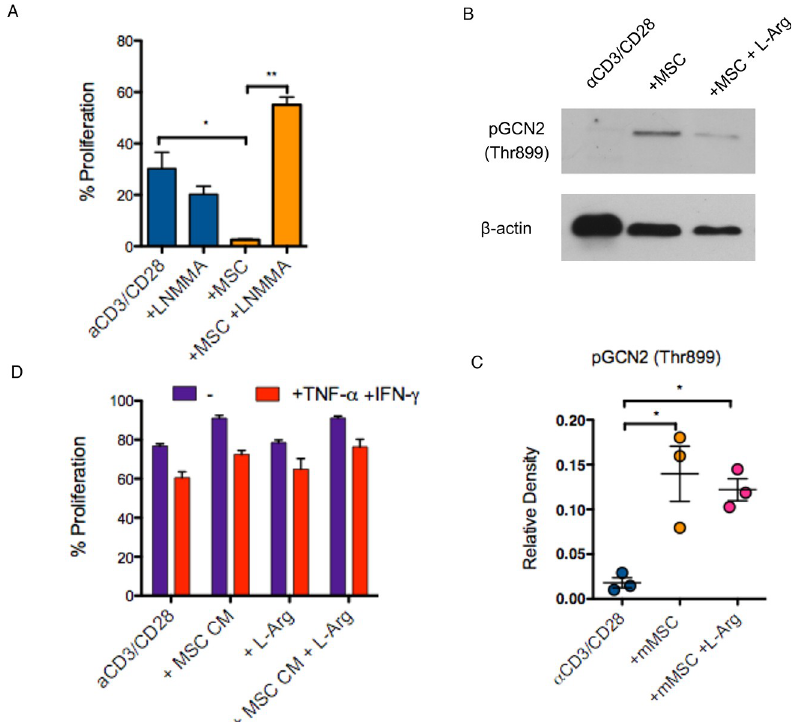
Fig 4. Mouse MSCs inhibit T-cell proliferation via NO production and induction of cellular stress response. (A) Proliferation of α CD3/CD28-activated CFSE-labelled CD4 + T-cells cultured in direct contact with mMSC ± iNOS inhibitor LNMMA (n = 4). (B) Representative immunoblot and (C) quantification of GCN2 phosphorylation (pGCN2) in α CD3/CD28-activated CD4 + T-cells co-cultured with mMSC or mMSC in the presence of L-Arg. (D) Proliferation of α CD3/CD28-activated CFSE-labelled CD4 + T-cells cultured in 100% non-activated or IFN- γ /TNF- α activated mMSC-conditioned medium.